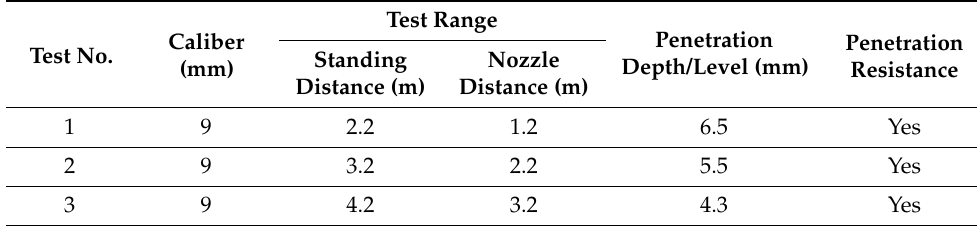
Table 9. Ballistic test results of kenaf/HDPE panel vest.